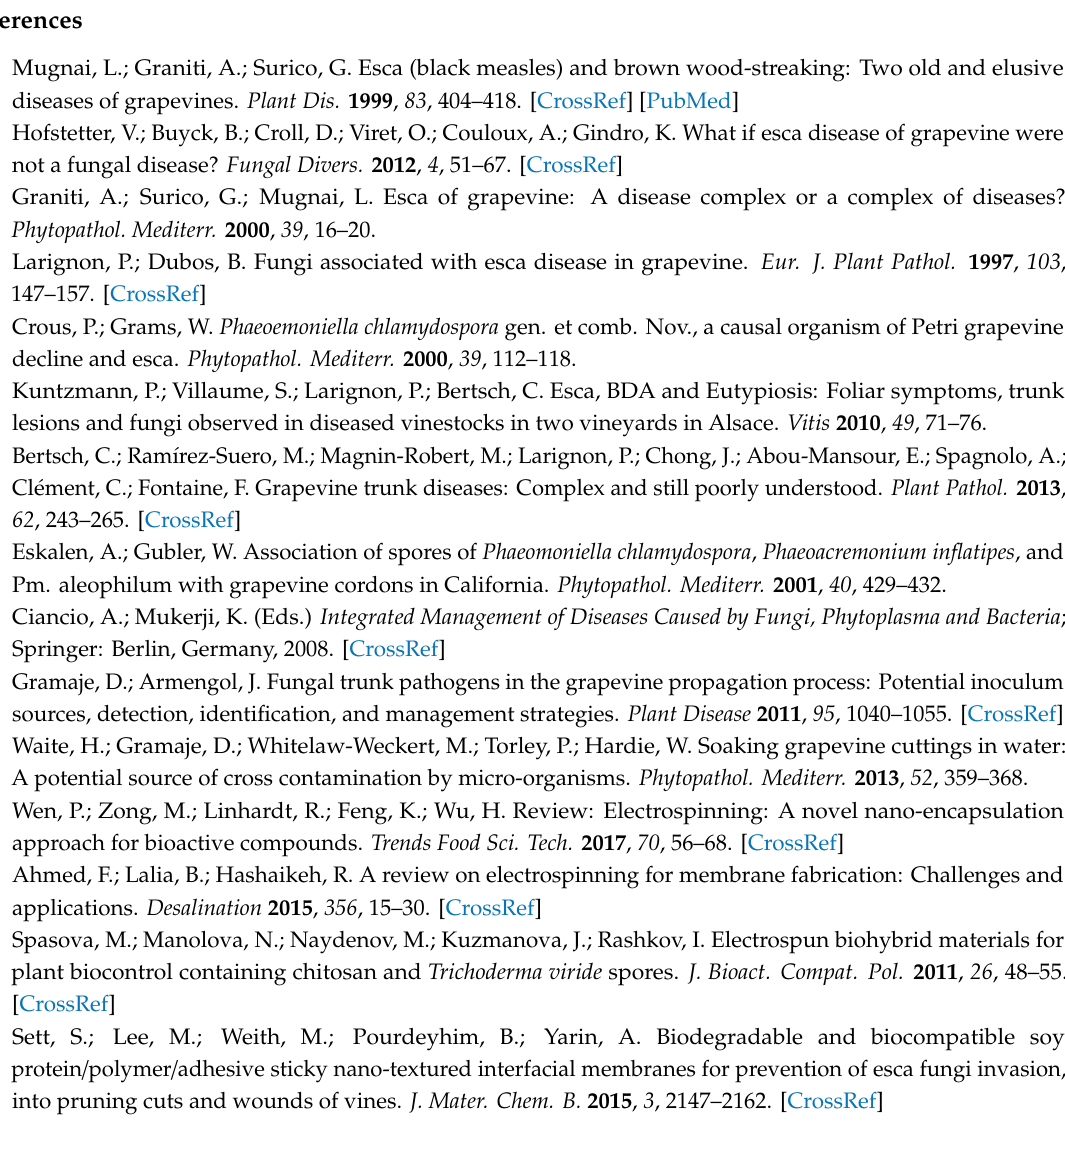
Figure S1: IR spectra of fibrous materials and nanoTiO 2